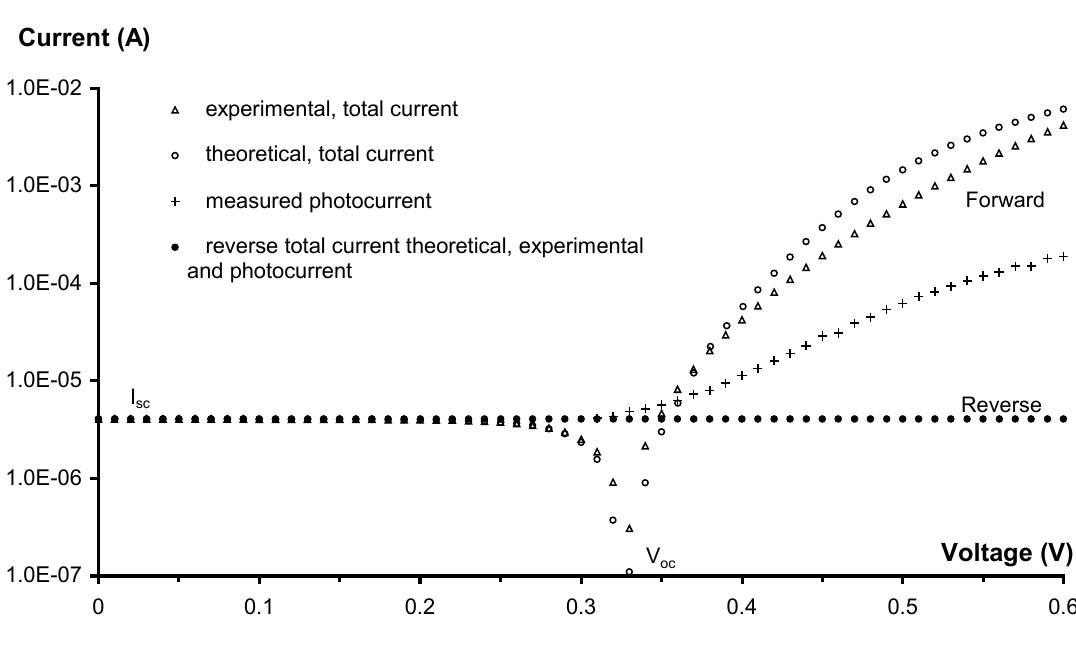
Figure 7. The experimentally and theoretically obtained I–V characteristics of the device under the illumination level L . The measured photocurrent is also incorporated in the 3 same plot for comparison